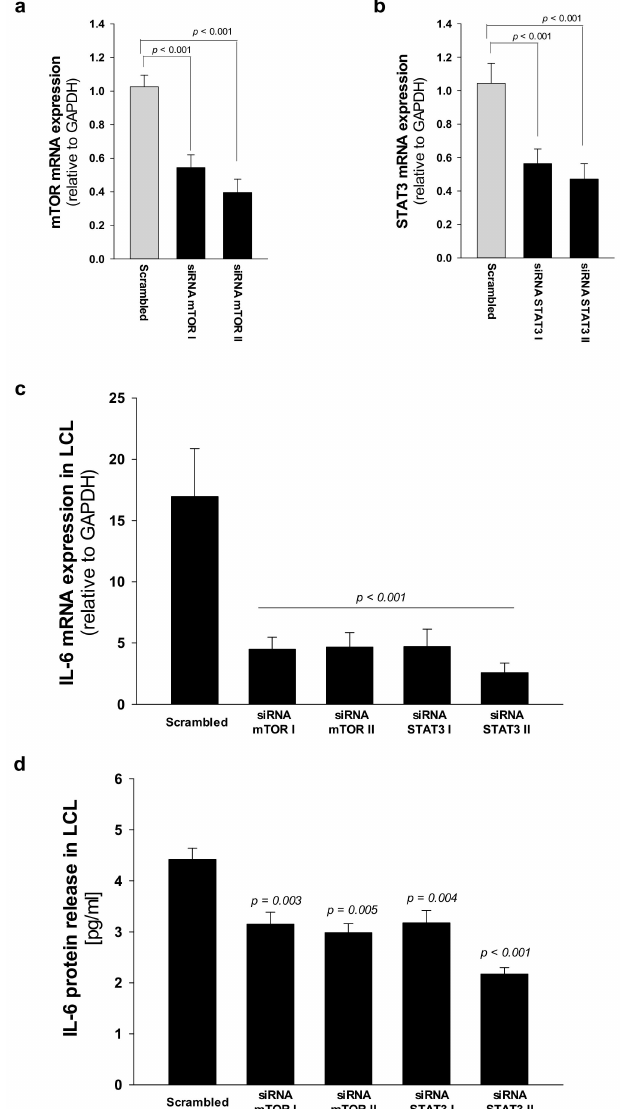
Figure 8. STAT3 and mTOR gene silencing inhibit IL-6 expression in LCL from SDS patients. ( a ) Reduced expression of mTOR mRNA after siRNA-mediated gene silencing. LCL obtained from UPN58,